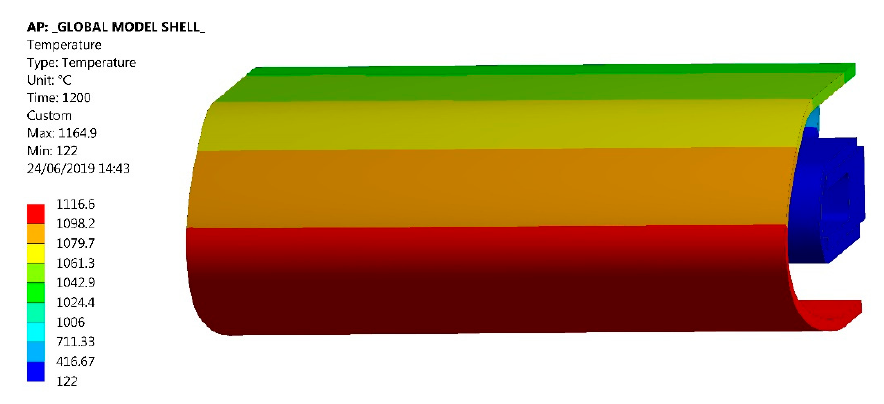
Figure 7. Temperature contour plot at 1200 seconds – Global coarse shell model.